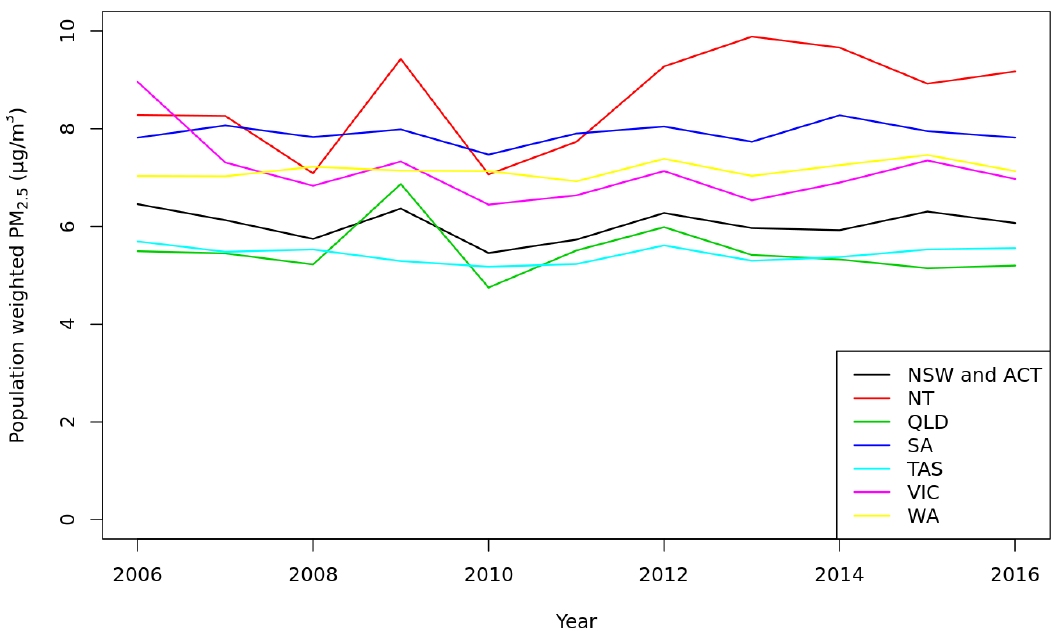
Figure 1. Time-series of population weighted ambient particulate matter (PM 2.5 ) concentrations (µg/m 3 ) across the years 2006–2016 for all Australian states—NSW, New South Wales; ACT, Australian Capital Territory; NT, Northern Territory; QLD, Queensland; SA, South Australia; TAS, Tasmania; VIC, Victoria; WA, Western Australia.